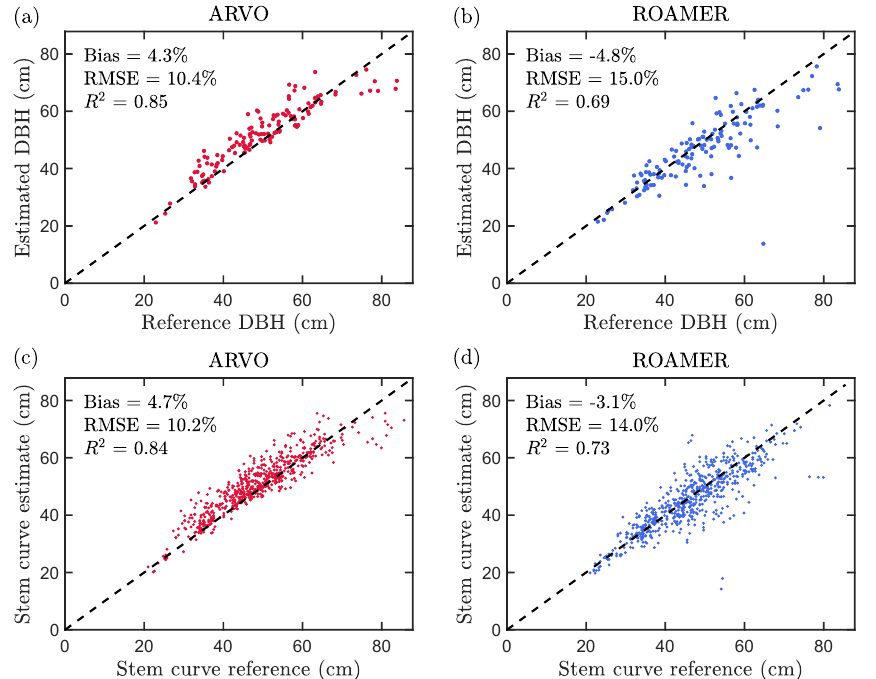
Figure 8. ( a ) Scatter plot for the DBH estimates measured from the point cloud data collected using the ARVO system vs. the reference DBH values. ( b ) The same as ( a ) but for the DBH estimates measured from the point cloud data collected using the ROAMER system. ( c ) Scatter plot for the stem curve estimates measured from the point cloud data collected using the ARVO system vs. the reference values of the stem curves. ( d ) The same as ( c ) but for the stem curve estimates assessed from the point cloud data collected using the ROAMER system.